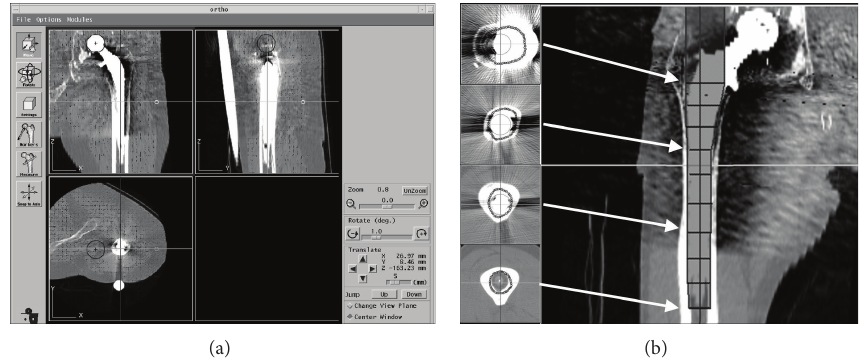
Figure 1: (a) Multiplanar reconstruction of the proximal femur on ORTHODOC. A minimum of 8 cross sections are defined on a coronal view. A perimeter around the bone is demarcated on each section. (b) A cutting path (hatched area) is automatically created.